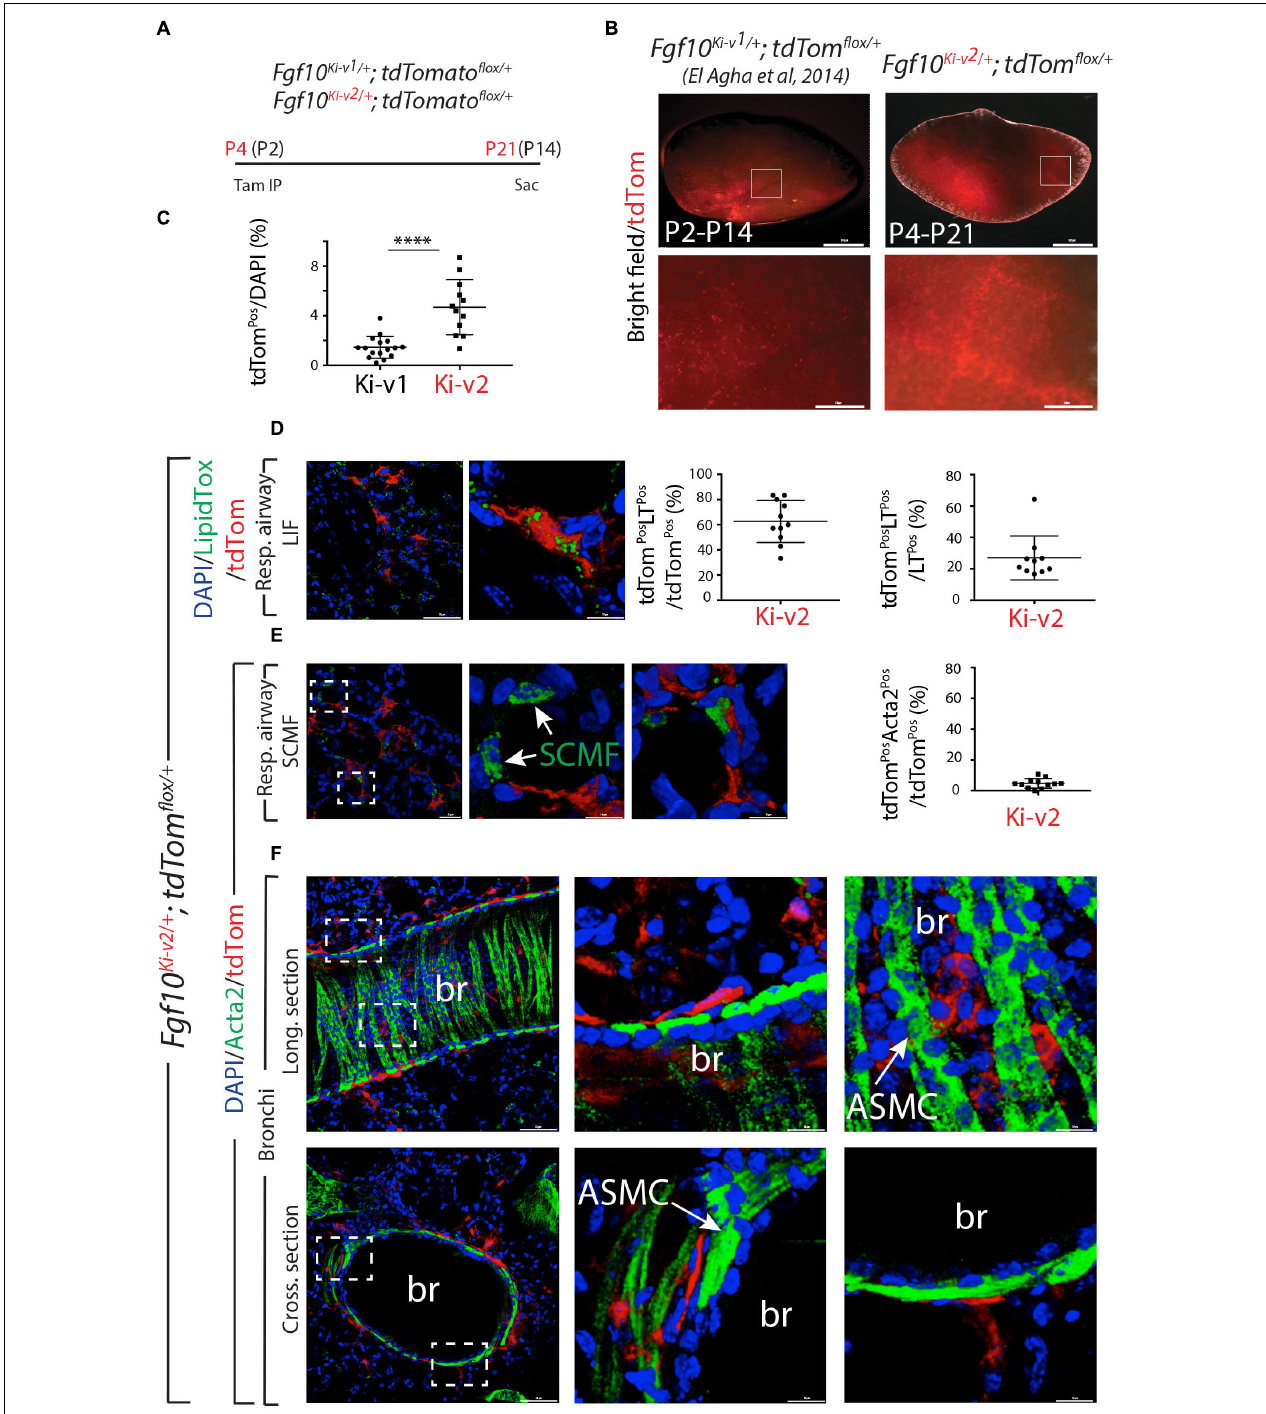
FIGURE 5 | FGF10 Pos cells labeled after birth do not contribute significantly to secondary crest myofibroblasts during alveologenesis. (A) FGF10 Pos cells in Fgf10 Ki - v 2 / + ; tdTomato flox / + pups were labeled in vivo at P4 and analyzed at P21. We also used previously generated Fgf10 Ki - v 1 / + ; tdTomato flox / + samples labeled between P2 and P14. (B) Whole-mount fluorescence images of Fgf10 Ki - v 2 / + ; tdTom flox / + and Fgf10 Ki - v 1 / + ; tdTom flox / + lungs showing more abundant labeled cells in Fgf10 Ki - v 2 / + vs. Fgf10 Ki - v 1 / + lungs. (C) ACTA2 IF on Fgf10 Ki - v 2 / + ; tdTom flox / + lungs shows little contribution of FGF10 Pos cells to SCMF (ACTA2 Pos tdTom Pos /ACTA2 Pos ). (D) Quantification of tdTom Pos cells. Br: bronchi. Scale bar in (B) : low magnification: 0.5 mm, High magnification: 50 µ m. Scale bar in (D) : low magnification: 50 µ m, High magnification: 10 µ m. Scale bar in (E) : Llow magnification: 25 µ m, High magnification: 10 µ m. Scale bar in (F) : Low magnification: 50 µ m, High magnification: 10 µ m. **** P ≤ 0.0001.